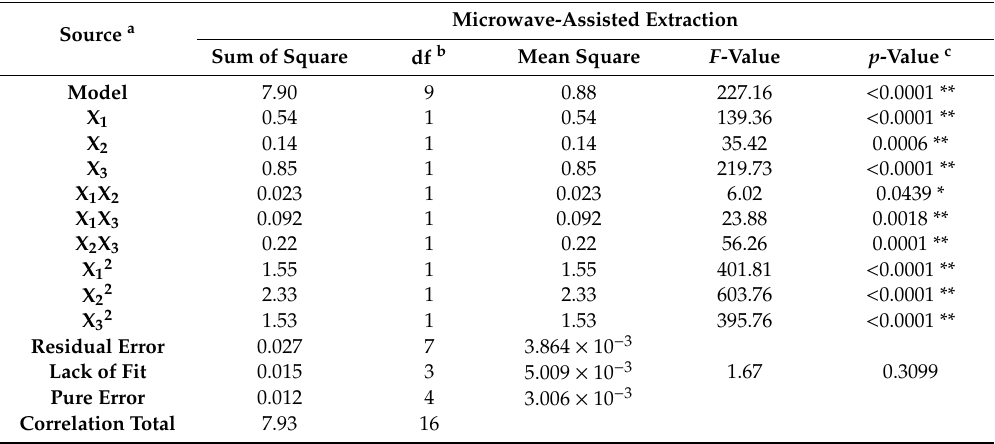
Table 2. Analysis of the variance of the regression equation and coe ffi cients of microwave- assisted